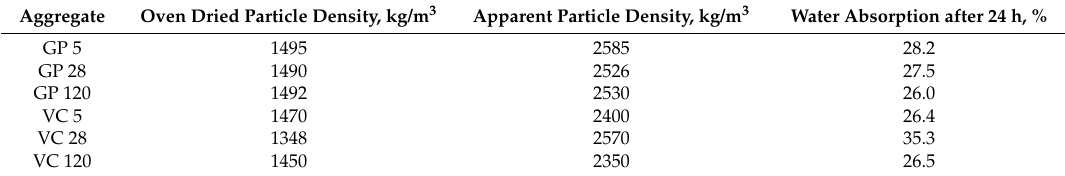
Table 2. Oven dried particle density, apparent particle density and water absorption of crushed and pelletized